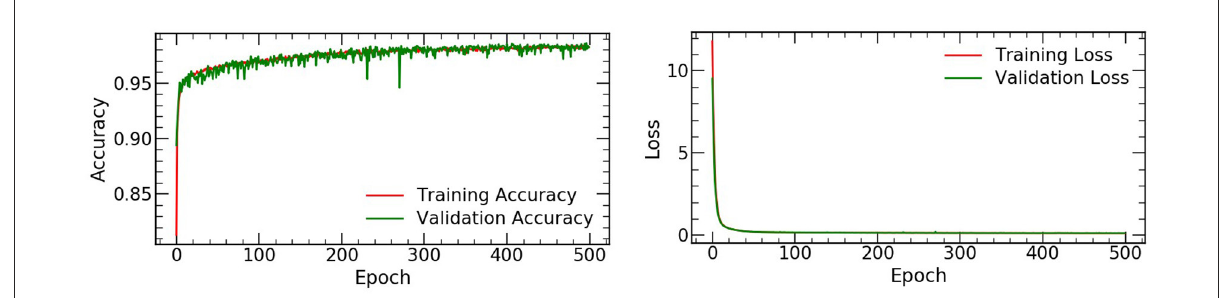
FIGURE2 The accuracy and loss values on the training and validation datasets.